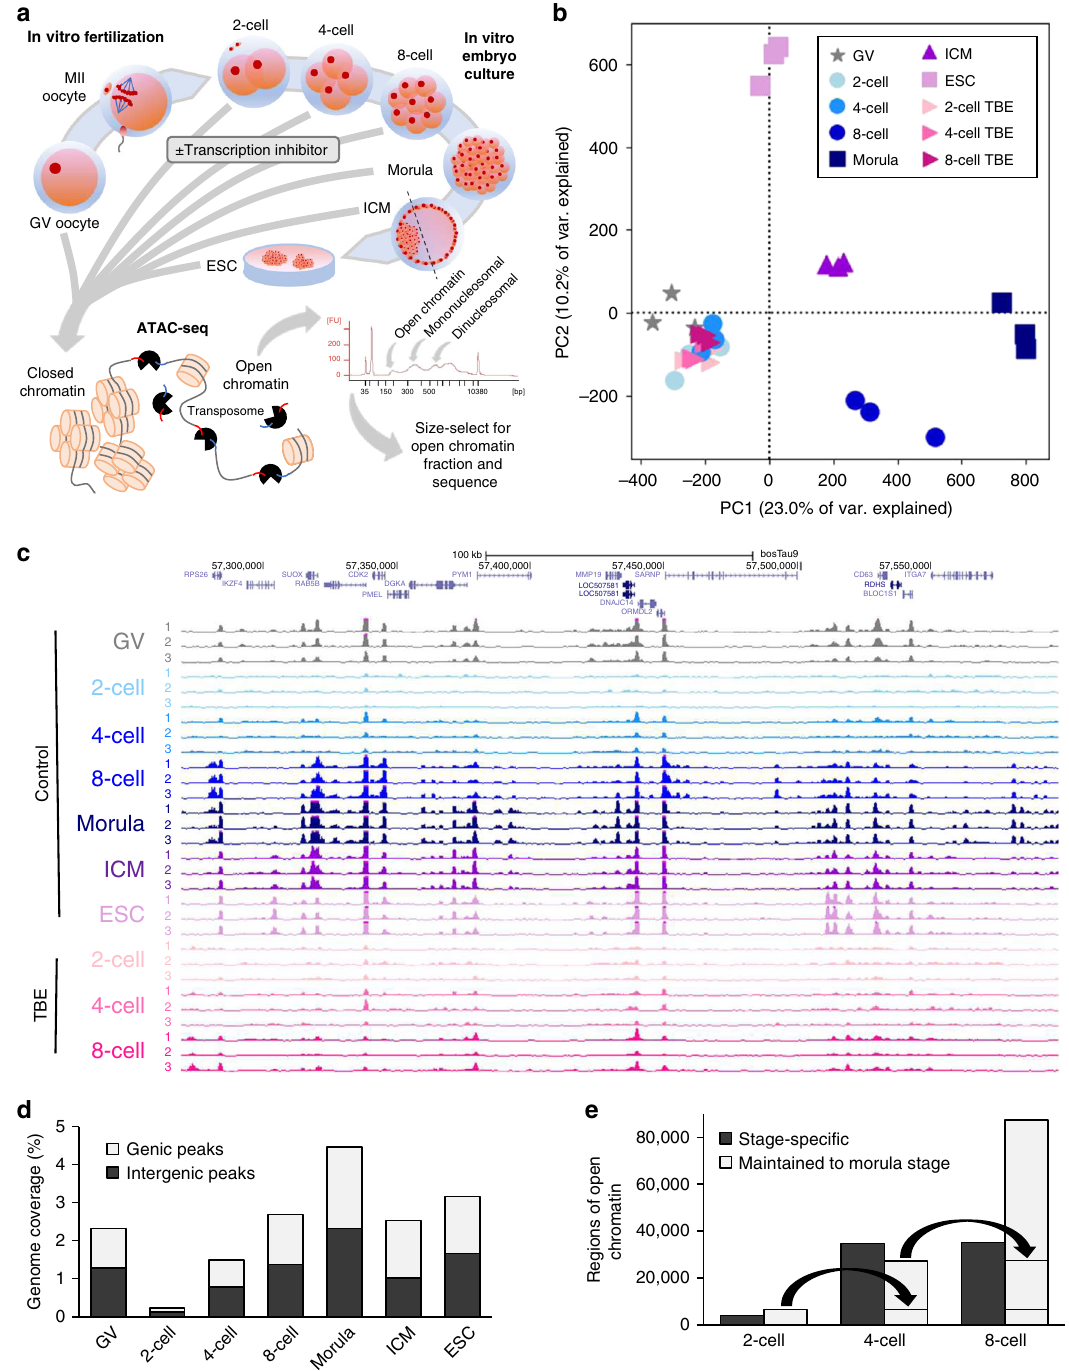
Fig. 1 Chromatin accessibility in bovine oocytes and in vitro preimplantation embryos. a Schematic of in vitro embryo production and ATAC-seq library preparation. b Principal components analysis (PCA) of ATAC-seq signal, normalized by fragments per kilobase million (FPKM), in 500 bp windows covering the whole genome. c Normalized coverage (FPKM) of replicate ATAC-seq libraries for each stage of development. d Proportion of genome that is covered by genic and intergenic ATAC-seq peaks, called from 30 million reads for each developmental stage. e Categorization of ATAC-seq peaks in 2-, 4-, and 8-cell embryos into stage-speci fi c and maintained peaks (accessibility maintained up until the morula stage). Maintained peaks are carried over from latter stages to show cumulative maintained peaks. Source data are provided as a Source Data fi stages, or 20 million reads when comparing transcription blocked embryos (TBE) with control embryos. Iterative random sub- sampling resulted in consistent ATAC-seq peak sets, indicating that subsampling did not introduce additional variation to peak calling (Supplementary Fig. 2). EGA embryos indicate highly dispersed chromatin 9,10 , lack of